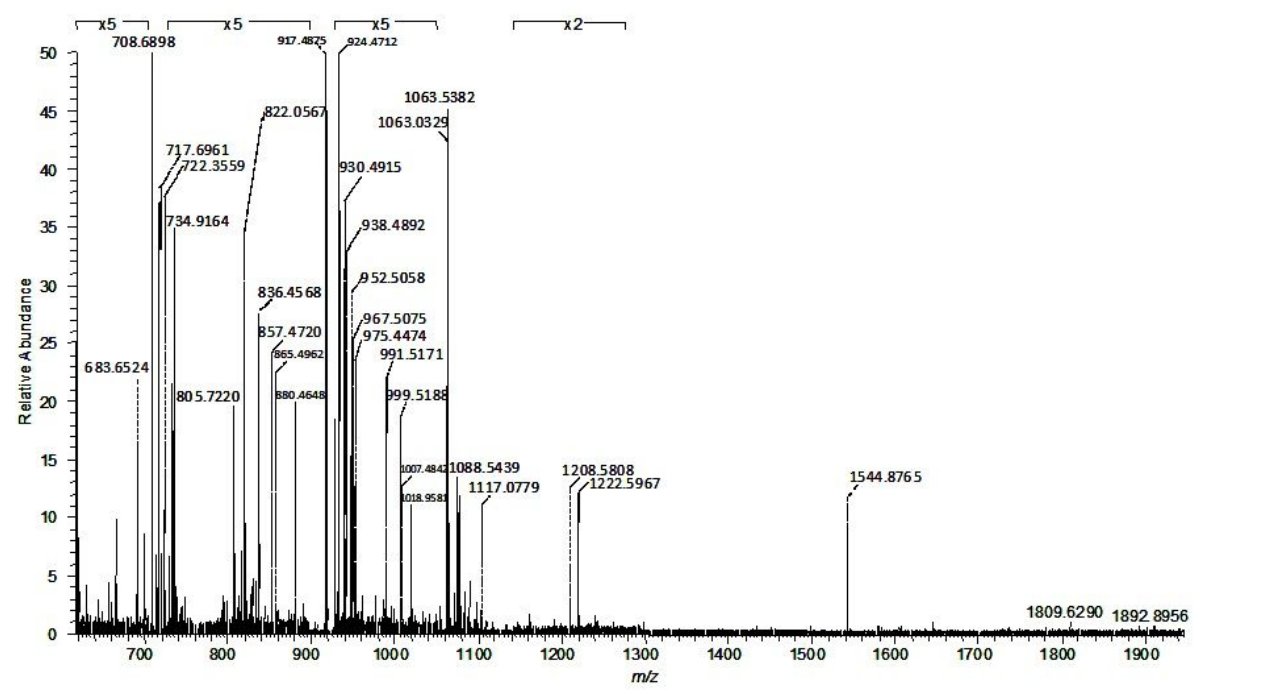
Figure 2. ( − ) NanoESI HR MS of ganglioside mixture isolated from human hippocampal tissue sample in temporal epilepsy. Sample concentration: 5 pmol·µL − 1 in MeOH; spray voltage: 0.70 kV; cone voltage: − 30 V; acquisition time: 2 min.